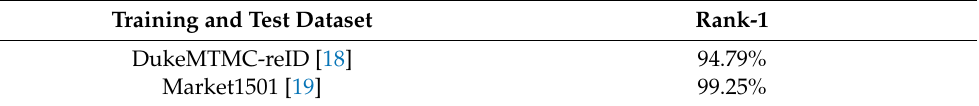
Table 4. Performance evaluation using DukeMTMC-reID [18] and Market-1501 [19]